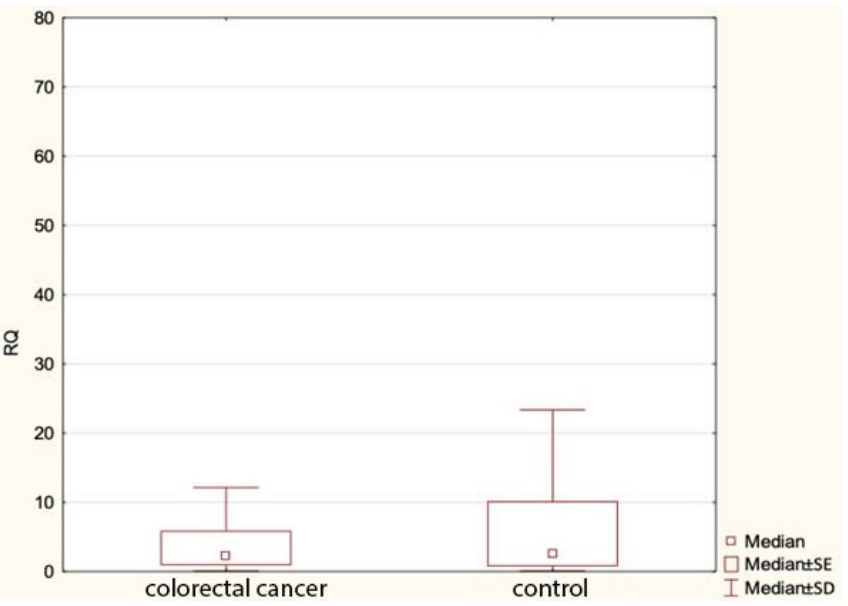
Figure 1. Expression of miR143 in colorectal cancer group and controls. RQ—relative quantification. Table 4. Expression of miRNA in controls. Table 5. Correlation of expressions of the studied miRNA in patients and